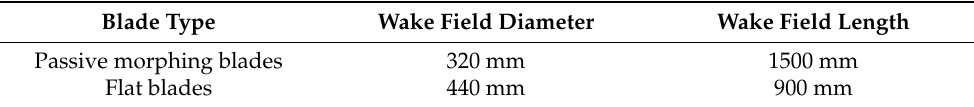
Table 2. Parameters of wake field.